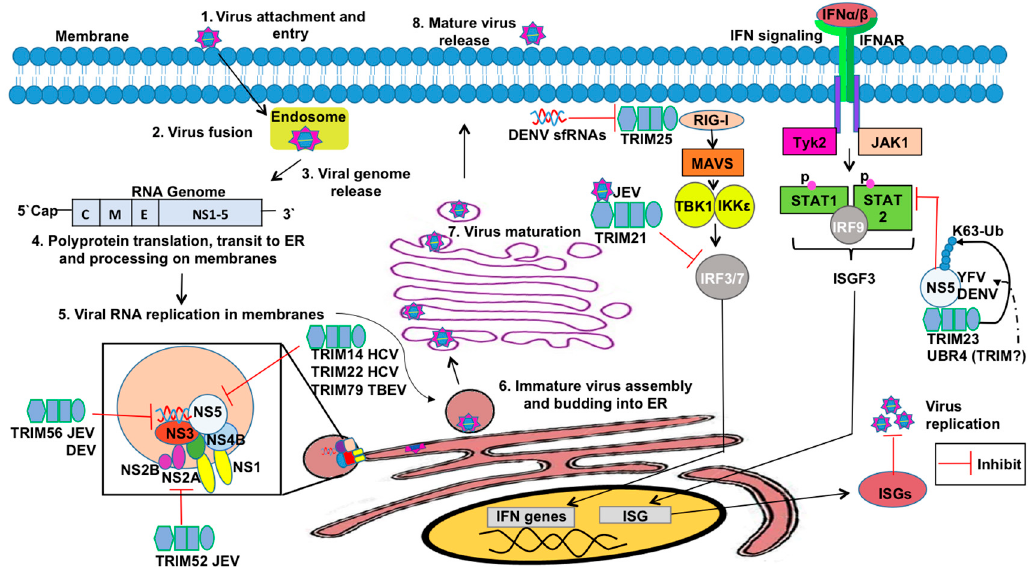
Figure 5. The roles of TRIMs in flavivirus infection and innate immune antagonism. Flaviviruses are internalized by receptor-mediated endocytosis and by clathrin-mediated endocytosis (1). Fusion of virus membrane with host endosomal membrane (2). RNA genome is released into the cytoplasm (3). The positive-sense genomic ssRNA is translated into a polyprotein, which is cleaved into all structural and non-structural proteins (4). Replication takes place at the surface of endoplasmic reticulum in cytoplasmic viral factories (5). In this step, the TRIMs restrict virus replication, degrading viral proteins such as NS2A in Japanese encephalitis virus (JEV) by TRIM52 and viral RNA inhibition in JEV and Dengue virus (DENV) by TRIM56. TRIM22 and TRIM79 degrade NS5 protein in hepatitis C virus (HCV) and tick-borne encephalitis virus (TBEV), respectively. Virus assembly occurs at the endoplasmic reticulum. The virion buds at the endoplasmic reticulum and is transported to the Golgi